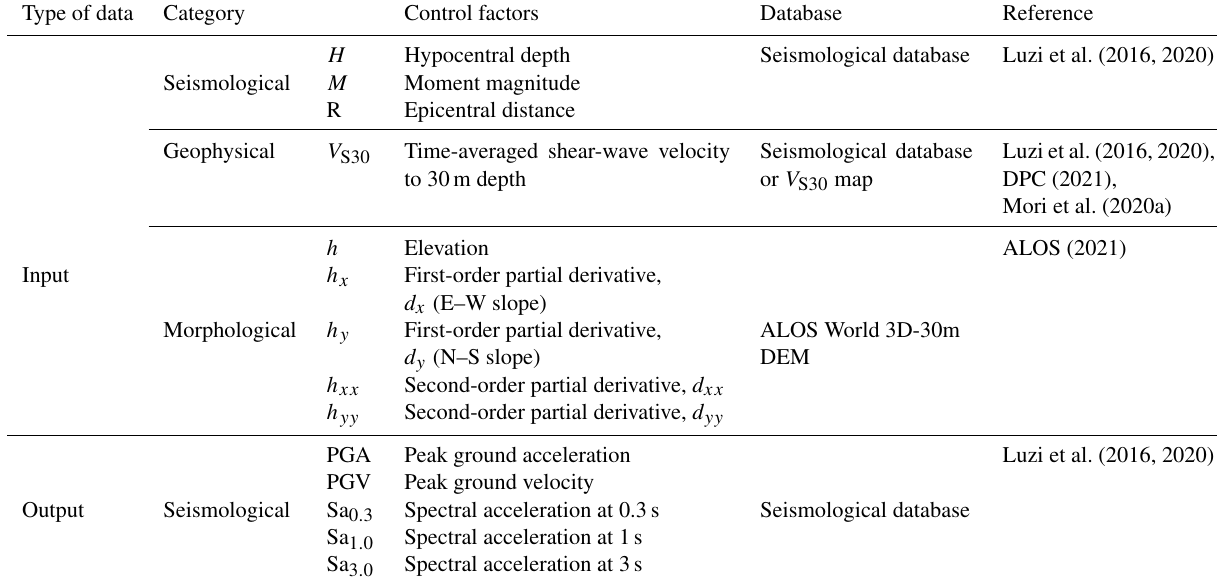
Table 1. Input and output data for ML training and